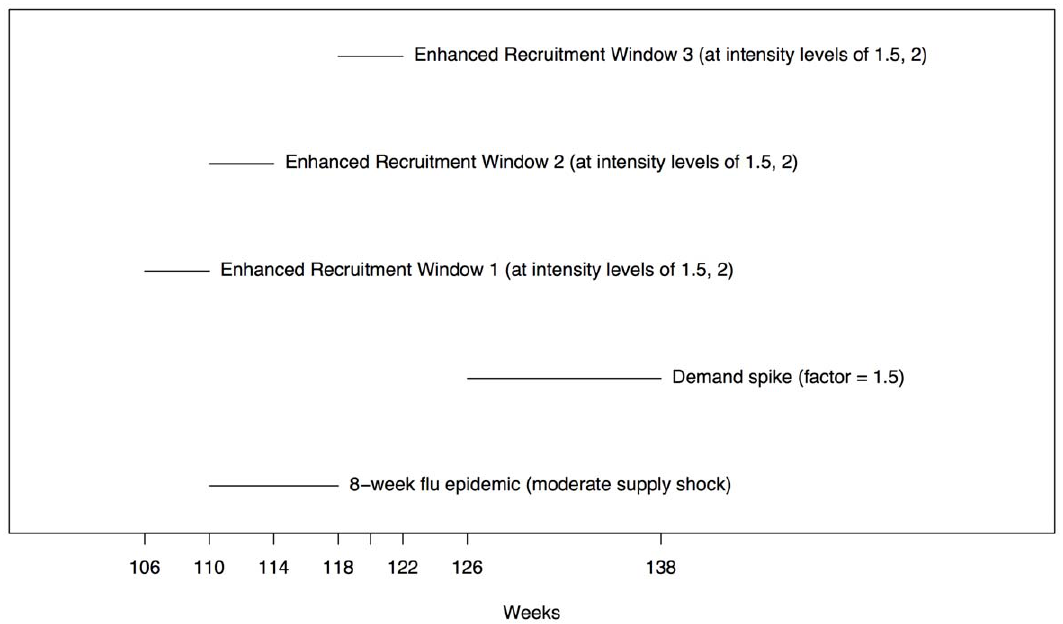
Figure 2. Timeline of events during a period with a moderate supply shock and a demand spike. The 8 -week supply shock (flu epidemic) starts in week 110 and is followed by an increase in demand by a factor of 1 : 5 starting in week 126 , and lasting for 12 weeks. We consider three different 4 -week windows of time for enhanced recruitment, each with 2 levels of intensity.